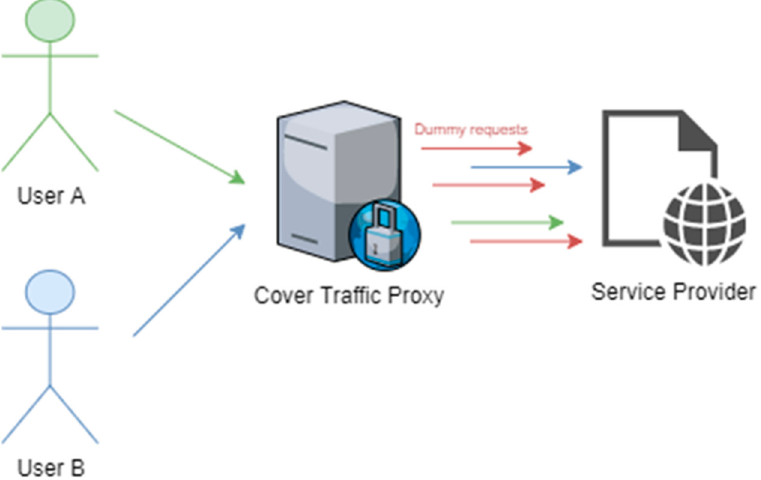
Figure 22. Conceptual overview of Cover Traffic—dummy traffic is generated to increase unlinkability set [21].